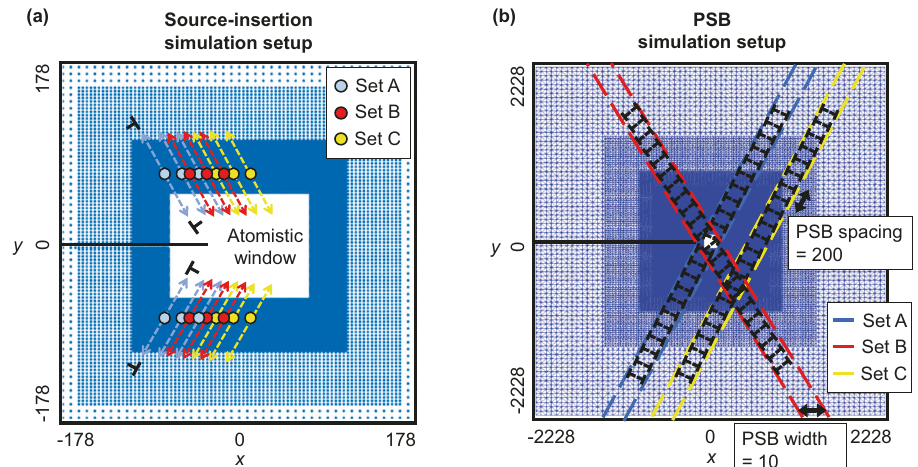
Fig. 6 Simulation set-ups for source-insertion and persistent slip bands (PSB). a In each set, an array of three Frank – Read sources was placed in the continuum just outside the atomistic window on each side of the crack. The sources within each array were set apart by 20 b , and each source emitted a dislocation dipole when its total resolved shear stress exceeded a critical value along the slip plane. The dislocation entering the atomistic window was constructed to be an anti-shielding dislocation gliding towards the crack tip region. b In each set, a pre-existing persistent slip band with width of 10 b and spacing of 200 b was constructed following the schematics by Sangid 54 . The PSB was arranged to intersect the crack tip region. The lengths given in this fi gure are normalized with respect to the magnitude of the Burgers vector, b , and the images are not drawn to [ − 1 1 3], respectively. The primary slip plane is the (1 1 − 1), which intersected the atomistic domain at the crack tip ranging from [268 b × 134 b ] to [536 b × 268 b ] (for crack plane at an angle of 58.5° from the horizontal, and slip consists primarily of simulations without continuum discrete dislocations). The crack was created by edge dislocations in the [0 1 1] direction. The atomistic domain was governed by removing three consecutive planes of atoms. The 2D hexagonal lattice consists of the Ercolessi and Adams 66 interatomic potential which has been shown to accu- three slip planes, 60° apart, one of which aligns with the horizontal crack plane. Edge dislocation slip occurs on all three planes. rately reproduce pure aluminum crack tip behavior 67 . The loading increment after The atomistic domain is governed by a ductile interatomic pair potential given each mechanical equilibration was 0.02 MPam 1/2 . The K I value at which the fi rst in ref. 68 (potential A). In the normalized units of the potential, the shear modulus dislocation nucleates during the initial loading cycle is denoted as K nuc I and was μ is 10.61 and the critical load for the nucleation of the fi rst dislocation is found to be 0.59MPa m 1/2 in the 3D fcc simulations. Given the importance of the K nuc I ¼ 6 : 8. For reference, Grif fi th cleavage is predicted to occur at K I = 7.5. In the dislocation nucleation process for crack advance, we report the value of Δ K I fatigue simulations, the prescribed loading increment after each mechanical normalized by K nuc I , to enable comparison across material systems equilibration was K = 0.1. For discrete dislocations in the continuum, the lattice resistance normalized by the shear modulus was prescribed to be 1.9E − 3. Source-insertion and PSB models . The simulation set up for the source-insertion 2D hexagonal lattice simulation setup . The 2D hexagonal lattice simulations and PSB cases is illustrated in Fig. 6. For source-insertion simulations, an array of three Frank – Read sources, separated by 20 b , was inserted into the continuum just were performed in a [4464 b × 4464 b ] continuum domain with an embedded